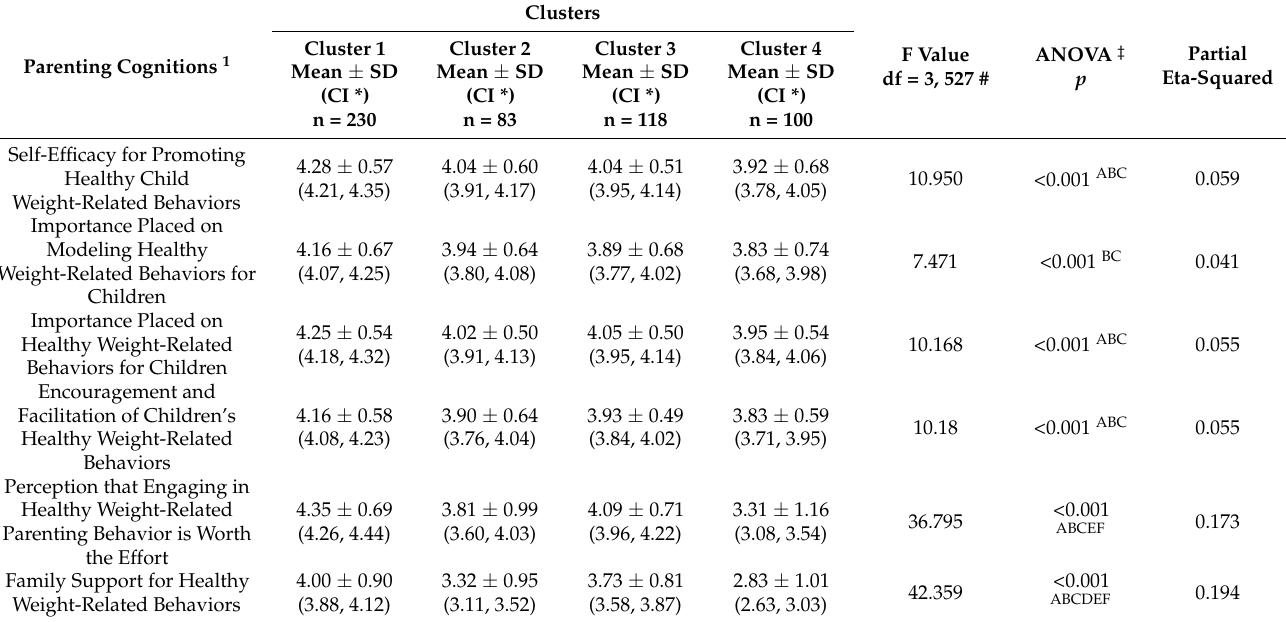
Table 3. Weight-Related Parenting Cognitions by Maternal Mental Health Status Cluster (N =